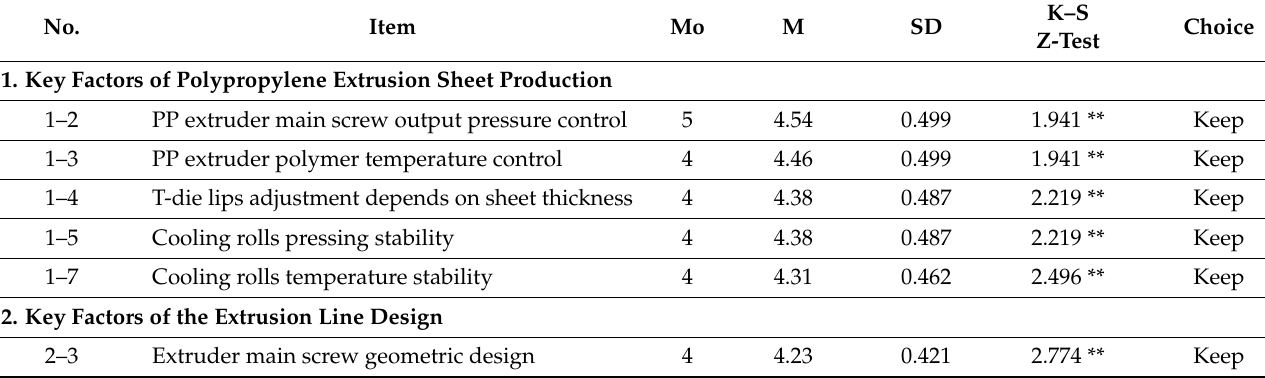
Table 7. Statistical analysis of the final Delphi